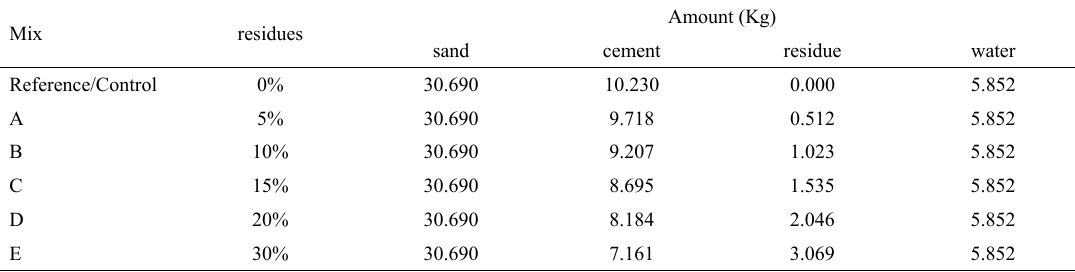
Table 1. Compositions (w%) of the filer residues cement mixtures to production of